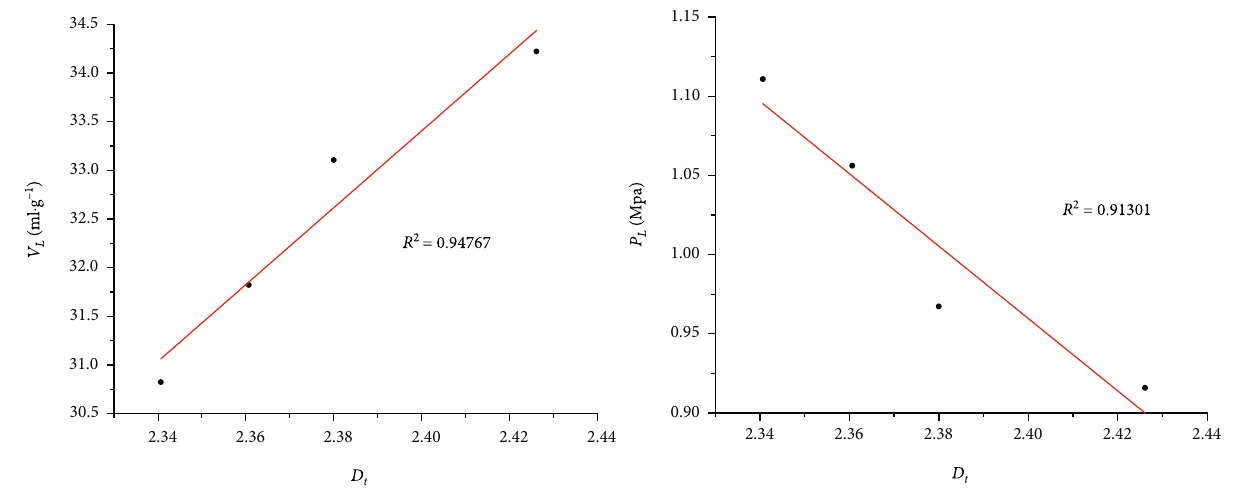
Figure 8: D e ff ects on gas t